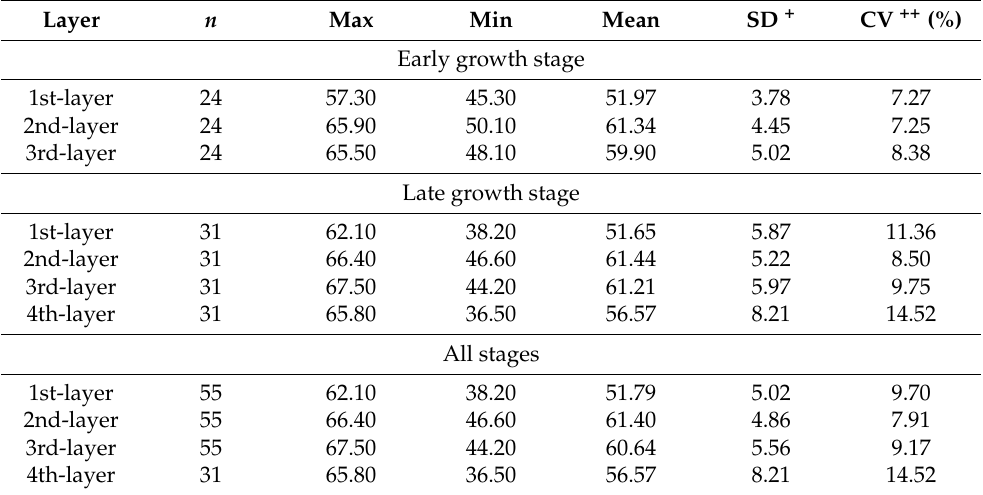
Table 2. Descriptive statistics of SPAD values across vertical canopy layers and maize growth stages.